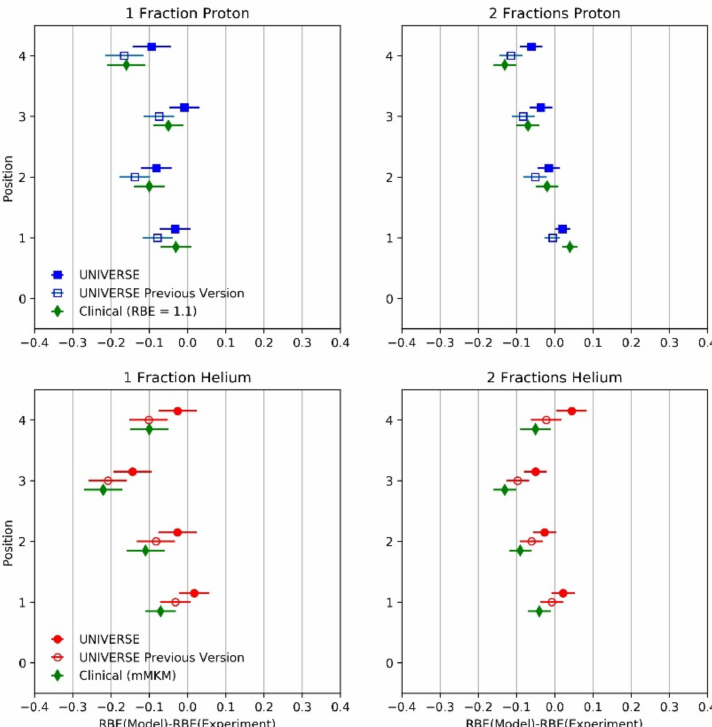
Figure 5. Difference between predicted RBE of TD 50 within the rat spinal cord after application of a proton SOBP ( upper panels; Saager et al. [23]) and a helium SOBP ( lower panels; taken from Hintz et al. [24]) in one ( left column) and two fractions ( right column) and different predictions. UNIVERSE considering (closed blue squares and red circles) and disregarding dose-rate/DNA damage repair (open blue squares and red circles) as well as a fixed RBE of 1.1 for protons and mMKM predictions for helium ions, representing current clinical approaches (green